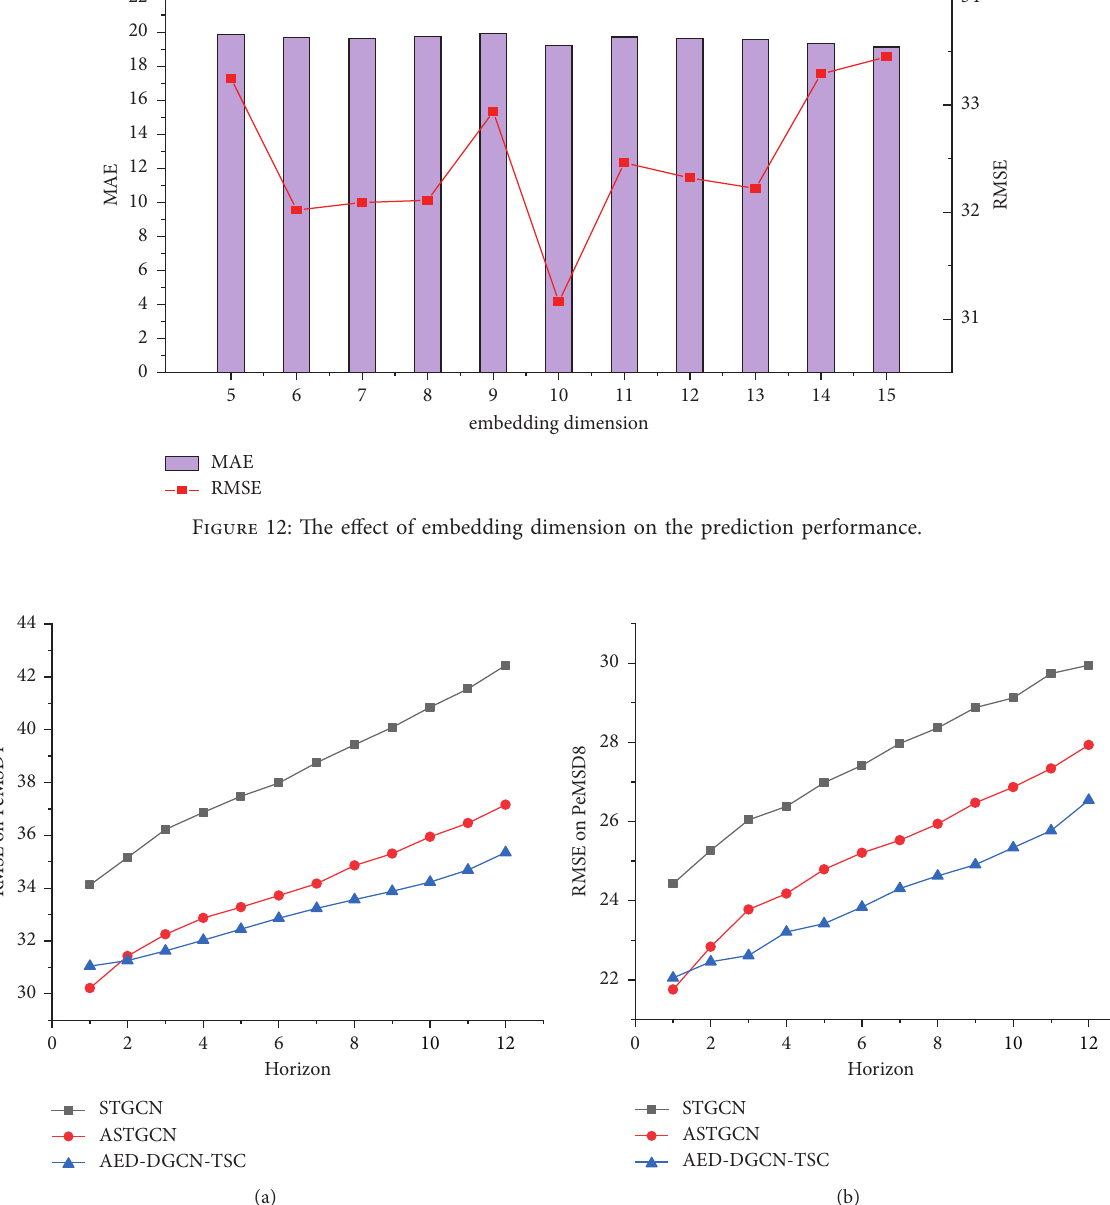
Figure 13: Prediction performance comparison on PeMSD4 and PeMSD8 datasets. (a) RMSE on PeMSD4. (b) RMSE on